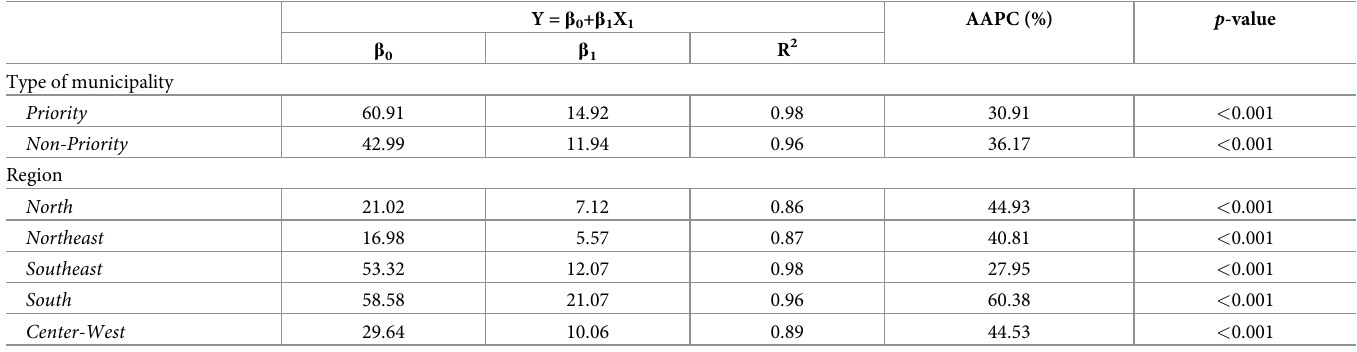
Table 1. Trend analysis of acquired syphilis rate in priority and non-priority municipalities and according to regions of Brazil, from 2011 to 2017. Database: National System of Aggravations and Notification—SINAN